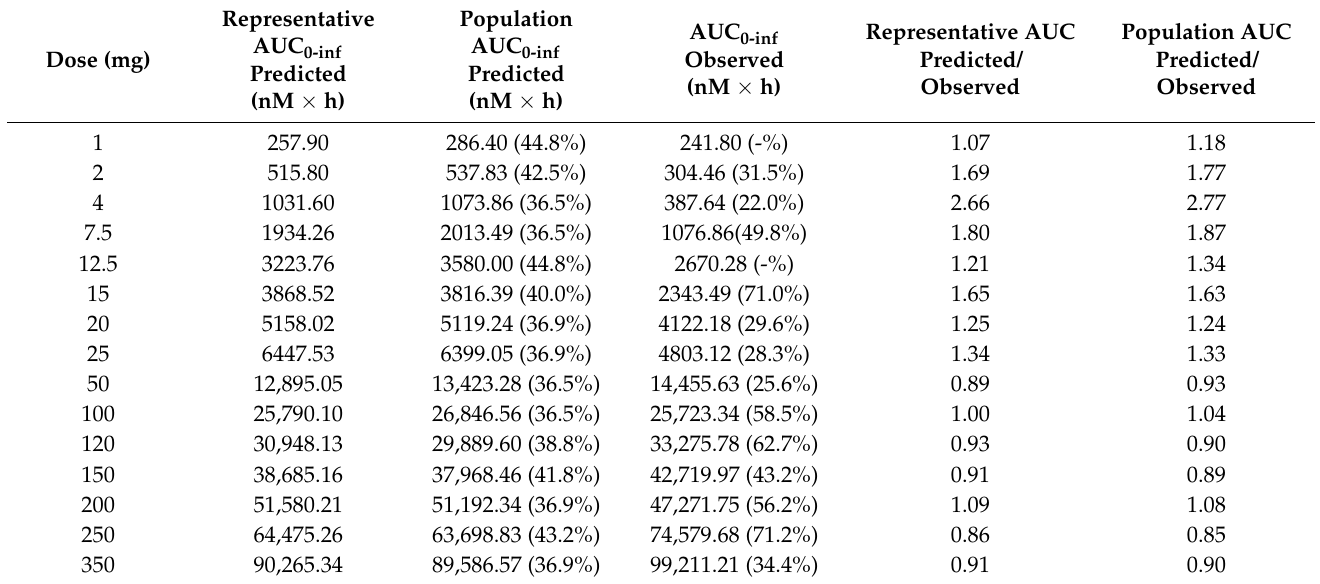
Table 1. Comparison of predicted vs. observed AUC 0-inf for siremadlin. Population representa- tive and total population-derived AUC 0-inf parameters were generated via first-order absorption mechanism and are presented as geometric means (%CV).